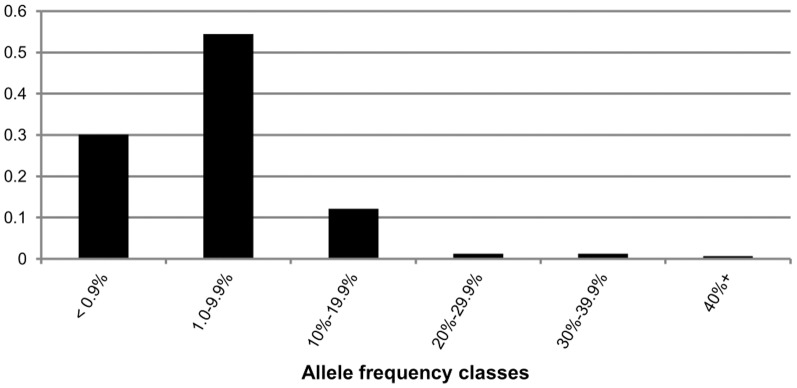
Frequency of different allele frequency classes.